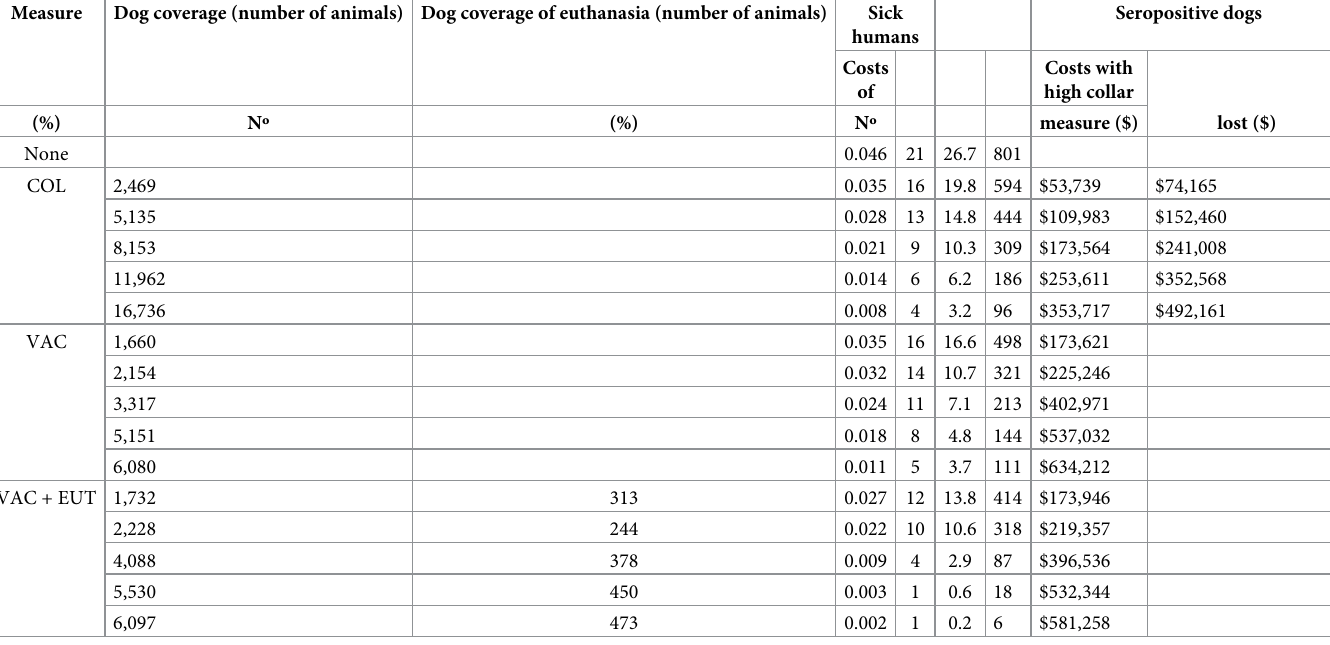
Table 1. Coverage of each measure, and prevalence reductions at the end of four years compared with the initial prevalence (0.046% of symptomatic humans and 27% of seropositive dogs, without control measures) and their associated costs. Measure Dog coverage (number of animals) Dog coverage of euthanasia (number of animals) Sick